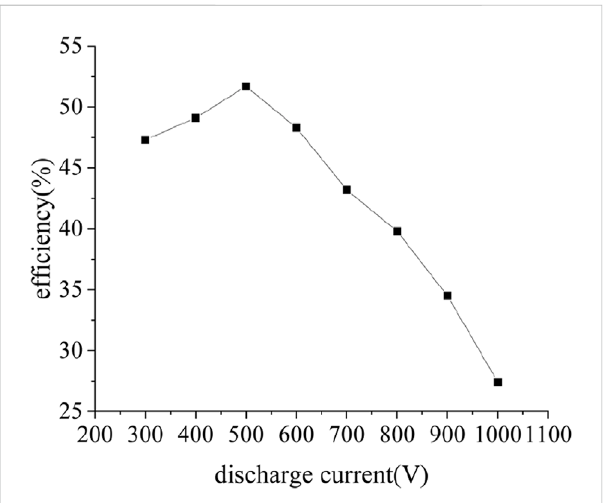
FIGURE 2 Simulated ef fi ciency with unchanged magnetic fi